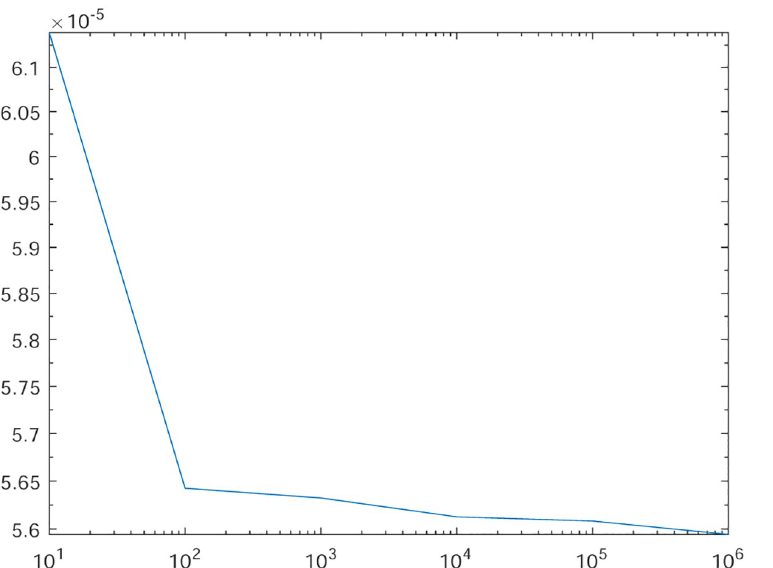
Fig 2. The behavior of the error with respect to the parameter θ for the Experiment